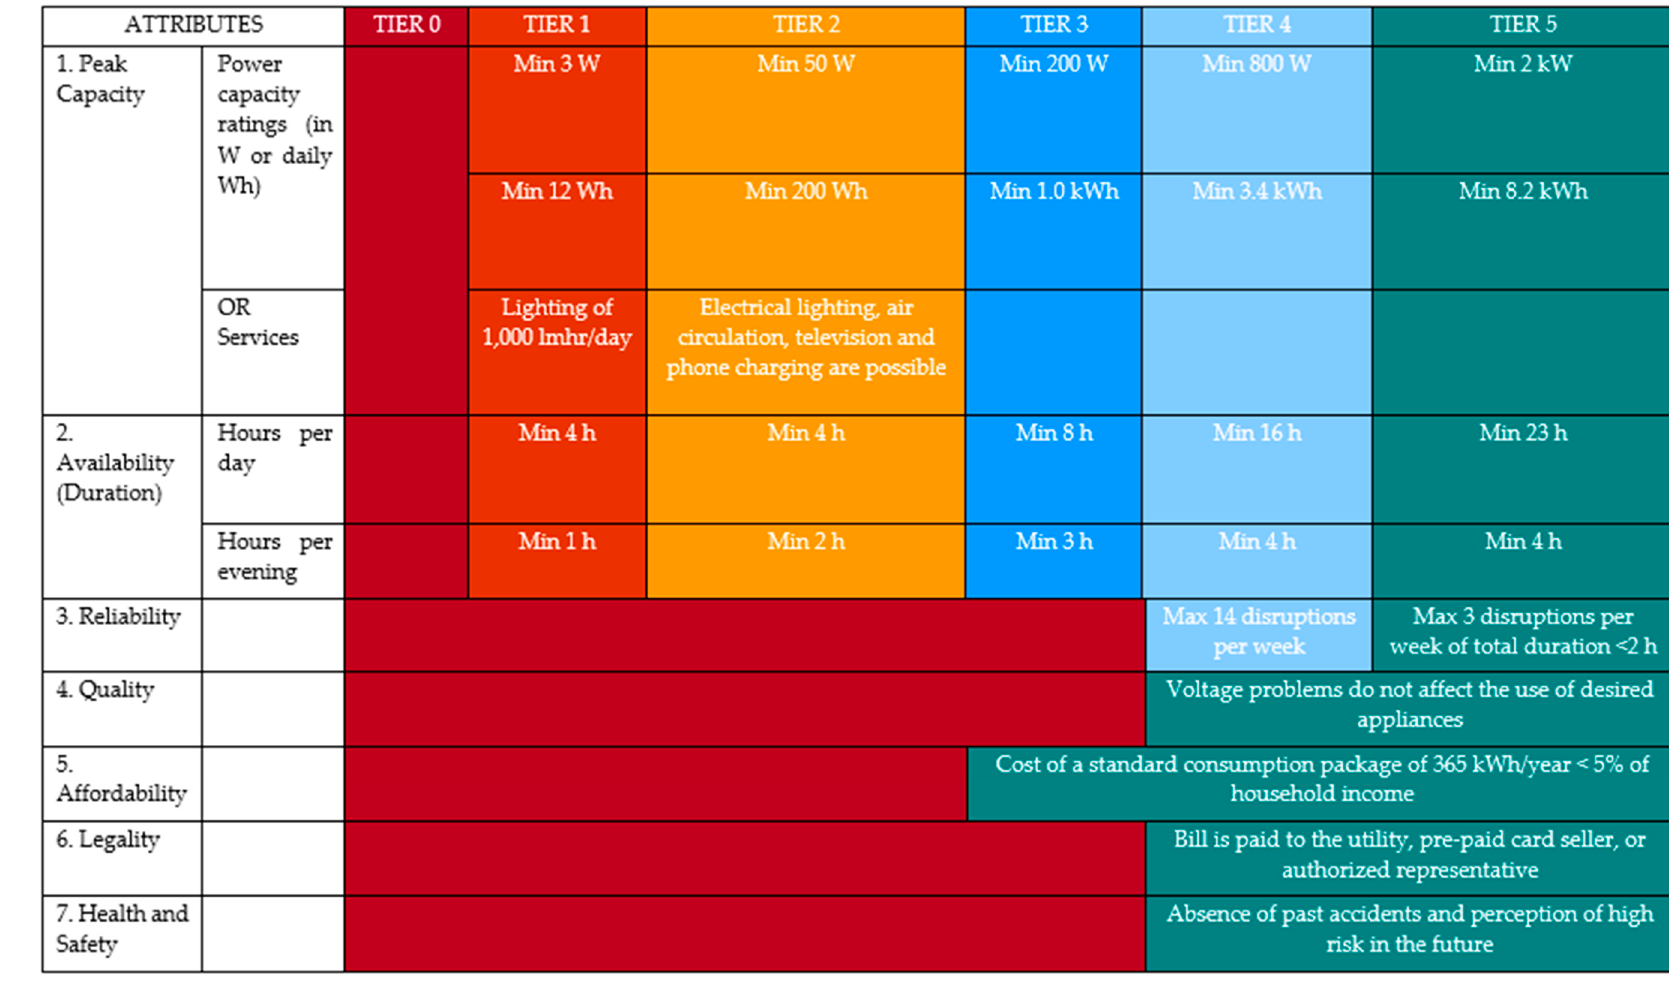
Figure 1. Multi-tier matrix for measuring access to household electricity supply (source: [9]).